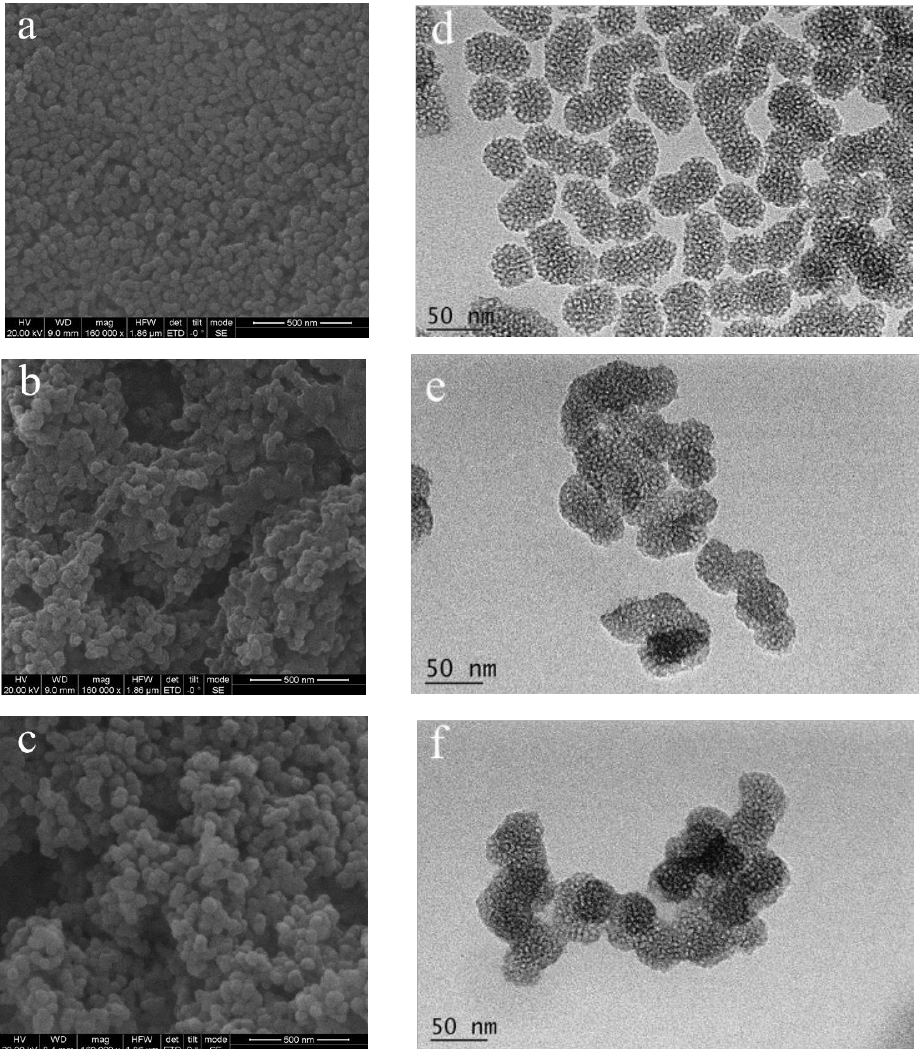
Figure 5. SEM images of MSN-NH 2 ( a ), MSN-NH 2 -AOS ( b ), and MSN-NH 2 -Cur-AOS ( c ). TEM images of MSN-NH 2 ( d ), MSN-NH 2 -AOS ( e ), and MSN-NH 2 -Cur-AOS ( f ). N 2 adsorption and desorption curves and parameters are shown in Figure 6 and Table 3. The specific surface areas of MSN, MSN-NH 2 , and MSN-NH 2 -Cur-AOS were 783.9, 648.1, and 286.3 m 2 /g, respectively, as measured using the BET method. The decrease in